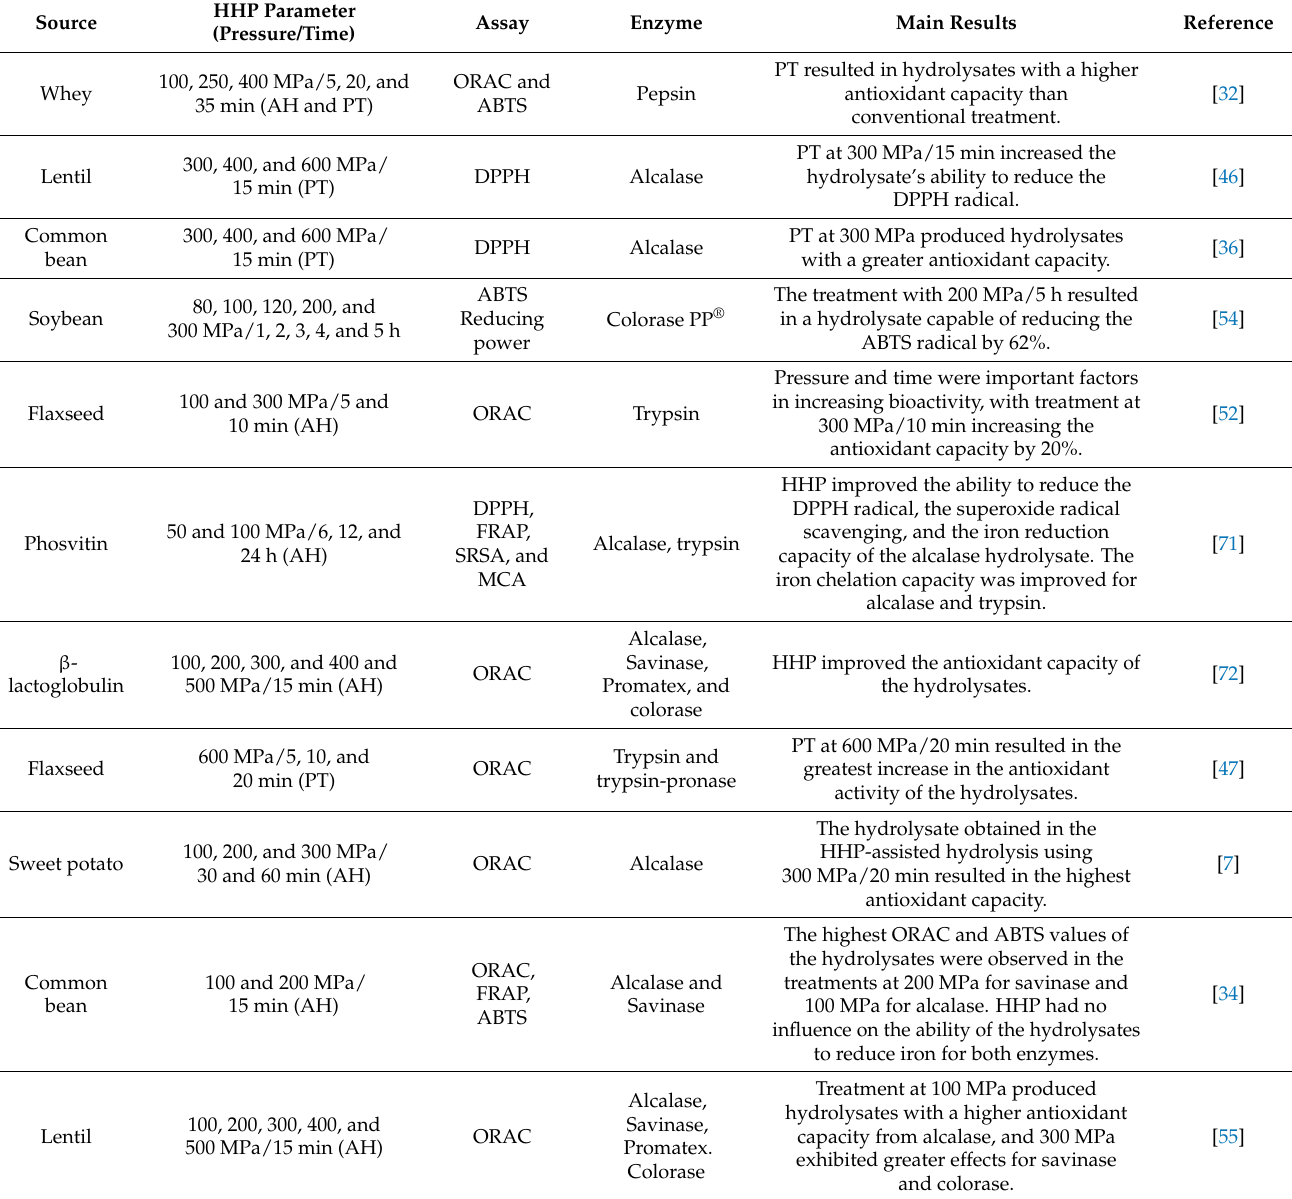
Table 2. Influence of HHP on the production of hydrolysates with antioxidant